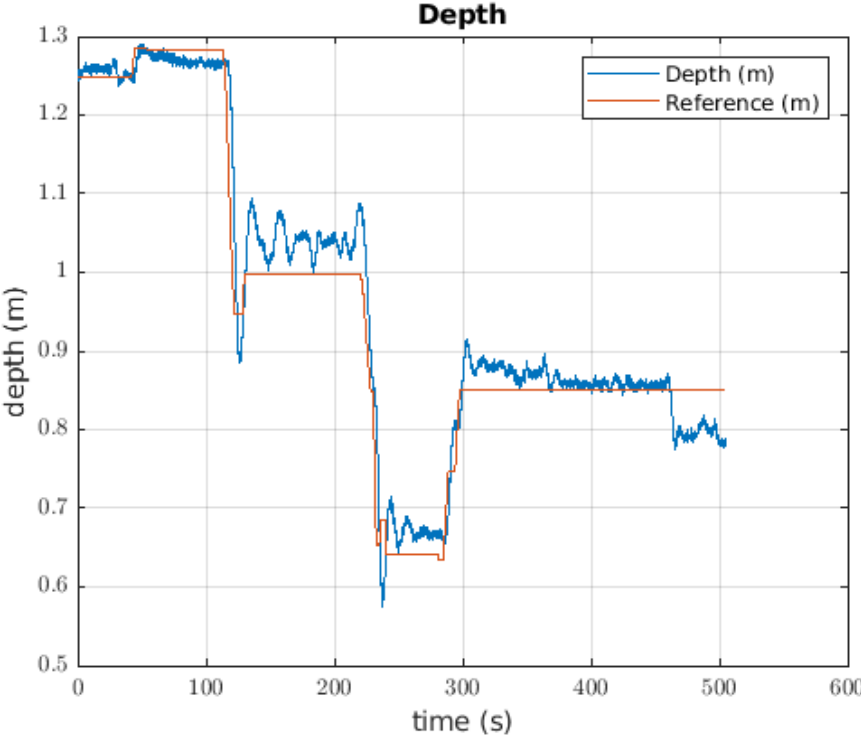
Figure 15. Response of the depth controller when the robot takes the